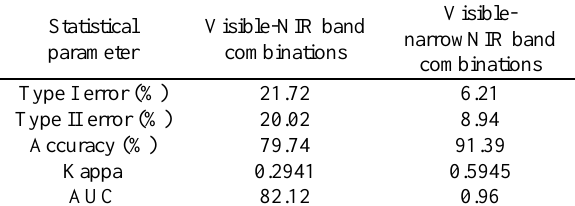
Table 4. Comparison of visible-narrow NIR and